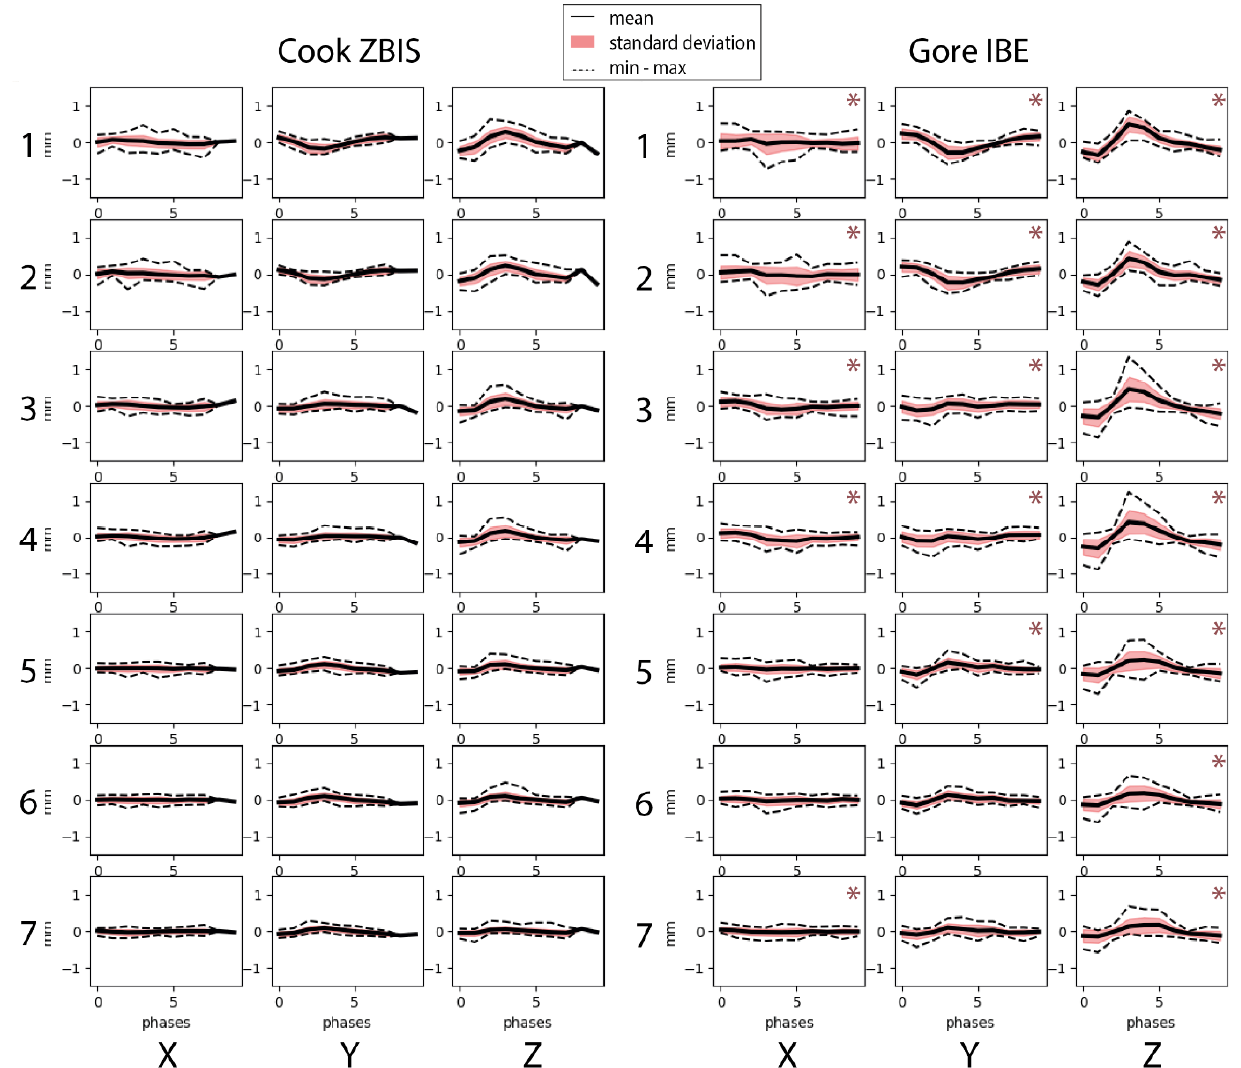
Figure 4. Displacement amplitudes in 𝑥 -(lateral), 𝑦 -(anterior–posterior) and 𝑧 -(craniocaudal) direction for the selected points on the Cook Medical Zenith bifurcated iliac side (ZBIS, left) and the Gore Excluder platform iliac branched endoprosthesis (IBE, right). The points were selected at the bifurcation of the main graft (Points 1 and 2), the IBD flow divider (Points 3 and 4), the distal markers of the IIA component (5 and 6) and the first bifurcation of the IIA (Point 7). * indicate larger displacement for that point for the IBE group than the ZBIS group in the corresponding direction. Table 2. Maximum displacement amplitudes, i.e., total displacement, in 𝑥 -(lateral), 𝑦 -(anterior– posterior) and 𝑧 -(craniocaudal) direction and the pathlengths of the selected points 1–7 for both the Cook Medical Zenith bifurcated iliac side (ZBIS) and the Gore Excluder platform iliac branched endoprosthesis (IBE) groups. The following points were selected: the bifurcation of the main graft (Points 1 and 2), the IBD flow divider (Points 3 and 4), the distal markers of the IIA component (5 and 6) and the first bifurcation of the IIA.* Lateral ( 𝒙 ) Displacement (mm) Anterior–Posterior ( 𝒚 ) Displacement (mm)